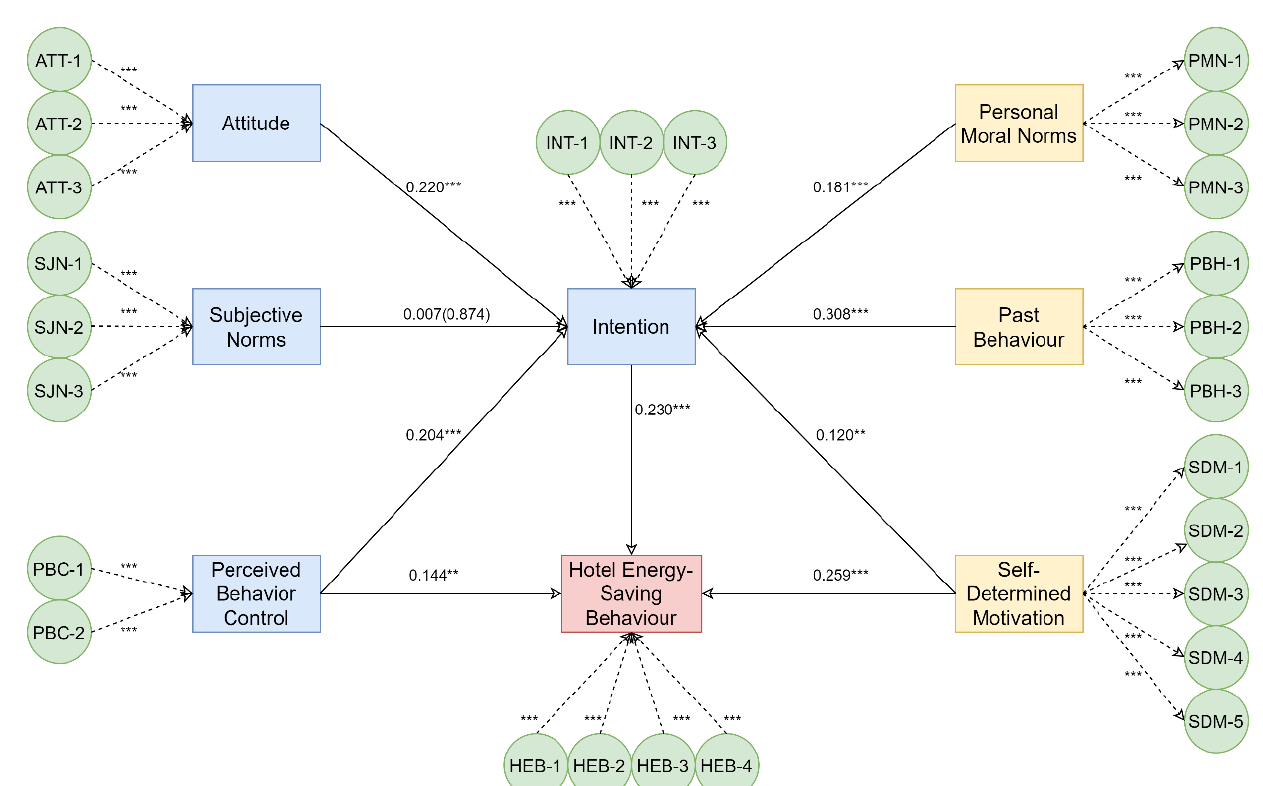
Figure 6. Structural modelling results of extended model II. Note: *** p < 0.001; ** p < 0.001 .